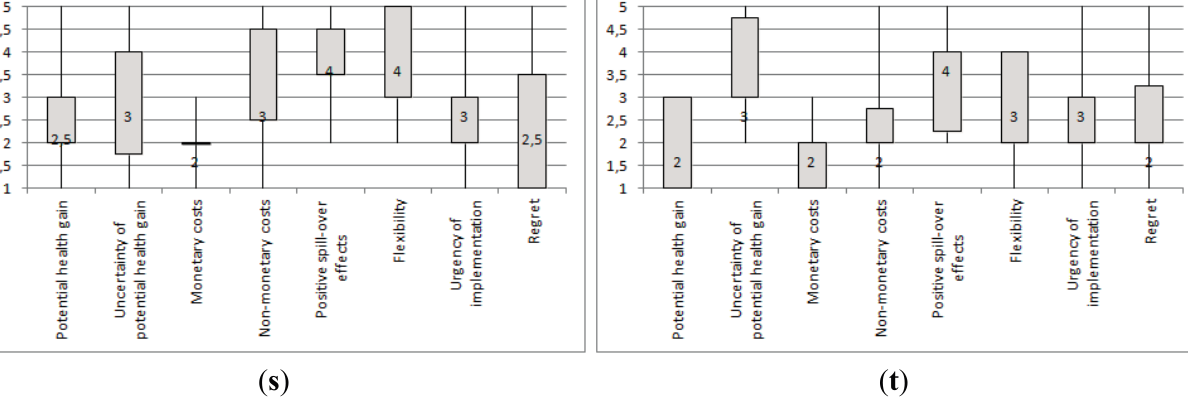
Figure 2. Box plots of the assessment of the two sample groups “Policy” and “Science” of the responses to climate change-induced infectious disease risk in Western Europe, using the eight assessment criteria:( a ) Monitoring, sample group “Policy”; ( b )